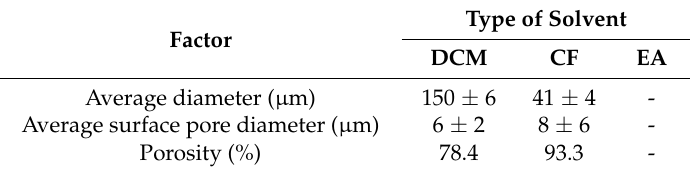
Figure 5. SEM images of PLGA (75:25) particles obtained by batch synthesis show the influence of organic solvent on microsphere formation and porosity with three solvents: dichloromethane (DCM), chloroform (CF) and ethyl acetate (EA). Table 2. Structure characterization of PLGA 75:25 microspheres obtained with three different solvent types, DCM, CF and EA. p < 0.05. The average diameters and porosity (%) were calculated based on SEM images with image analysis software ImageJ and weight ratios as depicted in Section 2.6.